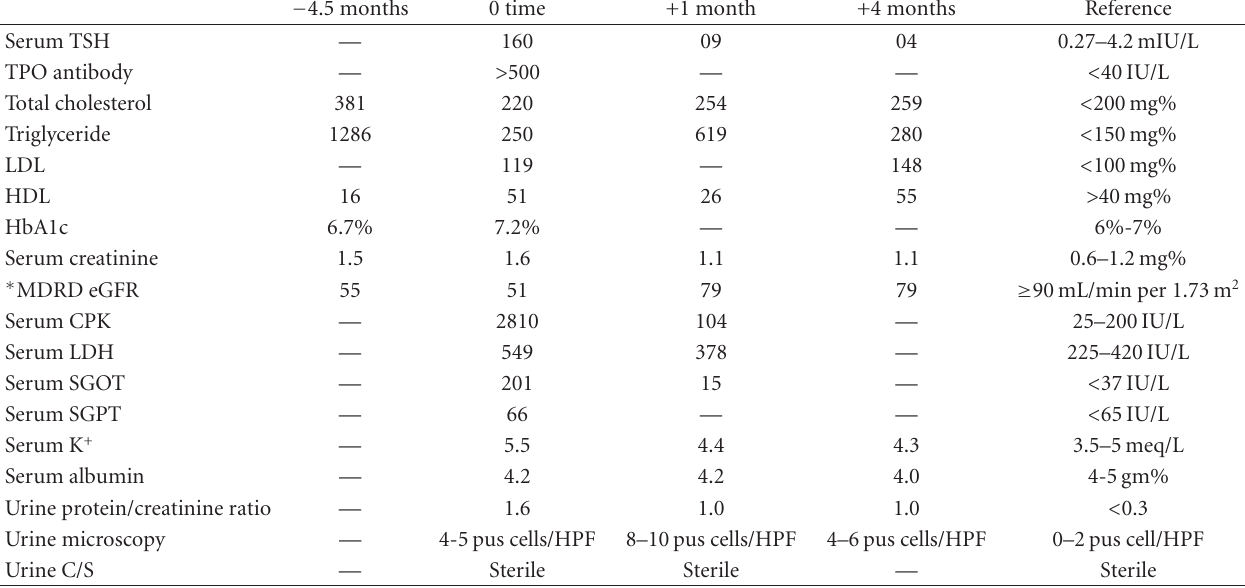
Table 1: Investigations at di ff erent time points.